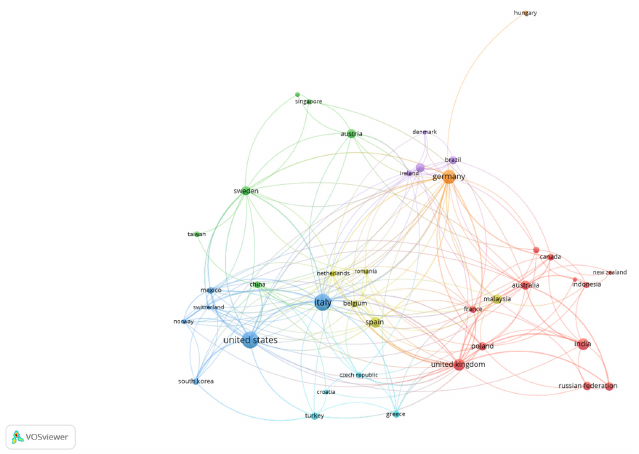
Figure 2. The most connected countries of the database by citations. Source: based on Scopus database edited by authors.